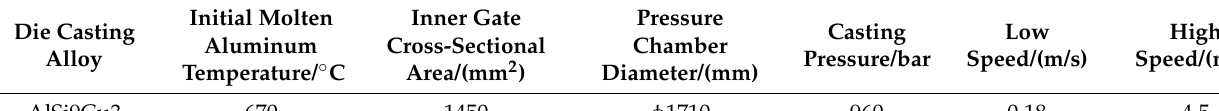
Table 2. List of simulation parameters of variable shell casting.